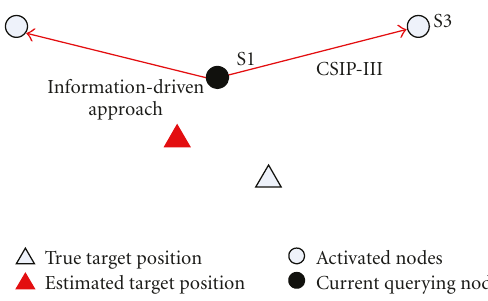
Figure 8: Comparison between information-driven approach and CSIP-III for node collaboration.